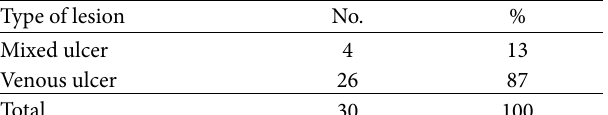
Table 4: Distribution by type of lesion.